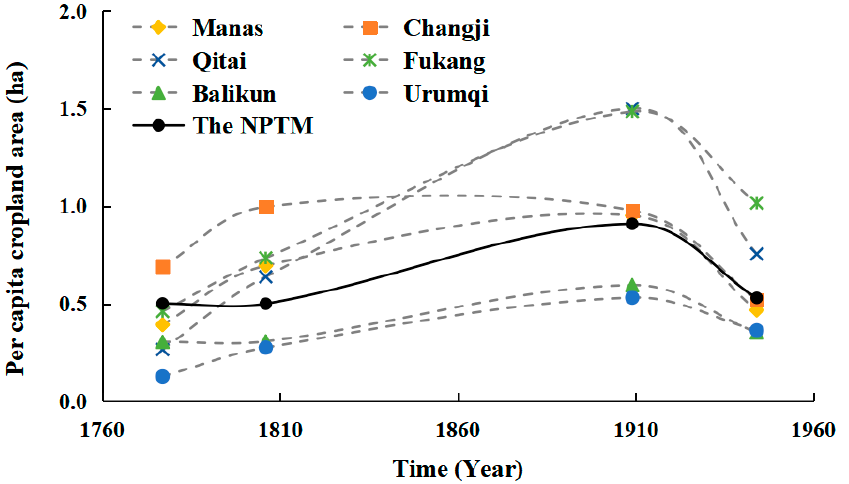
Figure 9. Computed regional and sub-regional per capita cropland areas in the Zhang dataset. The NPTM represents the northern piedmont of the Tianshan Mountains.